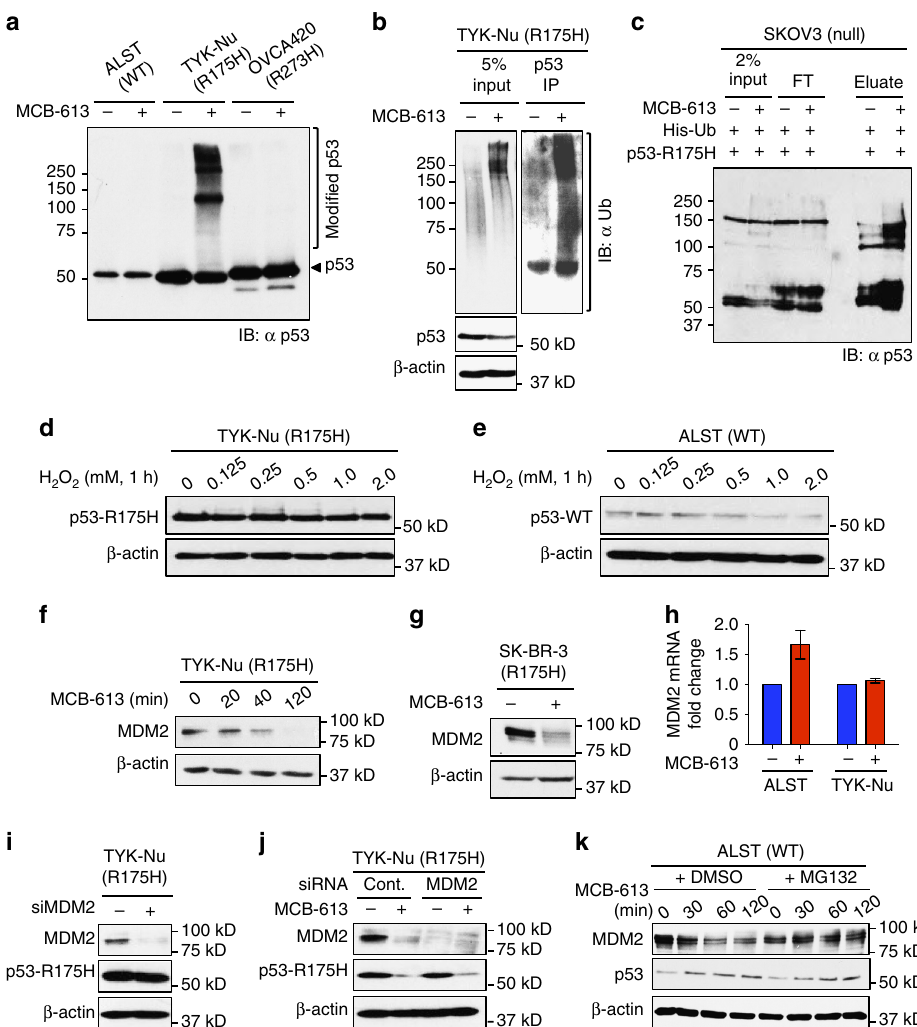
Fig. 4 MCB-613 causes increased ubiquitination of p53-R175H protein. a Higher migrating p53-R175H bands accumulate in TYK-Nu cells upon short-term (<20 min) MCB-613 treatment; but not in ALST (p53-WT) or OVCA420 (p53-R273H) cells. b MCB-613 caused increased ubiquitination of p53-R175H in TYK-Nu cells. c Increased ubiquitination of ectopic p53-R175H-HA upon MCB-613 treatment in SKOV3 cells. d Effect of increasing concentrations of H 2 O 2 (1 h) on p53-R175H levels in TYK-Nu cells. e Effect of increasing concentrations of H 2 O 2 (1 h) on p53-WT levels in ALST cells. f , g MCB-613 causes decrease in MDM2 levels in f TYK-Nu and g SKBR-3 cells. h Effect of MCB-613 on MDM2 mRNA levels in ALST and TYK-Nu cells. Values are normalized mean ± s.e.m. ( n = 3). i MDM2 knockdown (48 h) has no effect on p53-R175H levels in TYK-Nu cells. j Effect of MCB-613 on p53-R175H turnover is independent of MDM2. k MG132 reversed MCB-613 induced MDM2 turnover in ALST concentrations, H 2 O 2 has no effect on p53-R175H levels (Fig. 4d, e). These results indicate that the effect of MCB-613 on p53-WT and R175H mutant is not mediated by cellular oxidative stress.